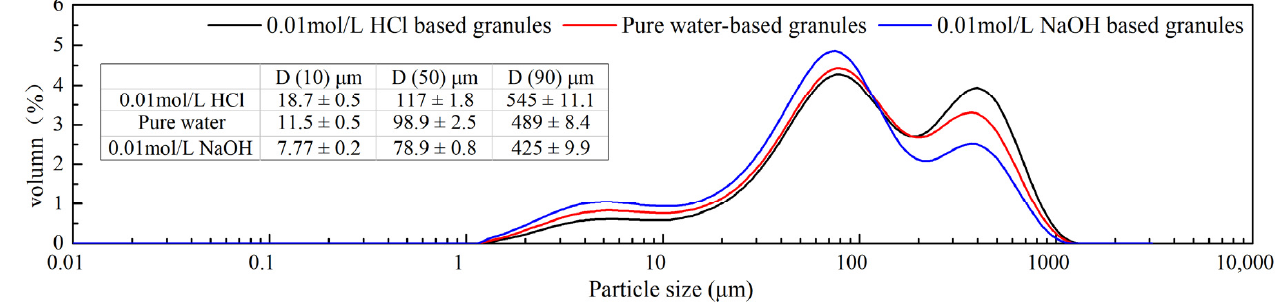
Figure 10. Different media-based granule particle size and size